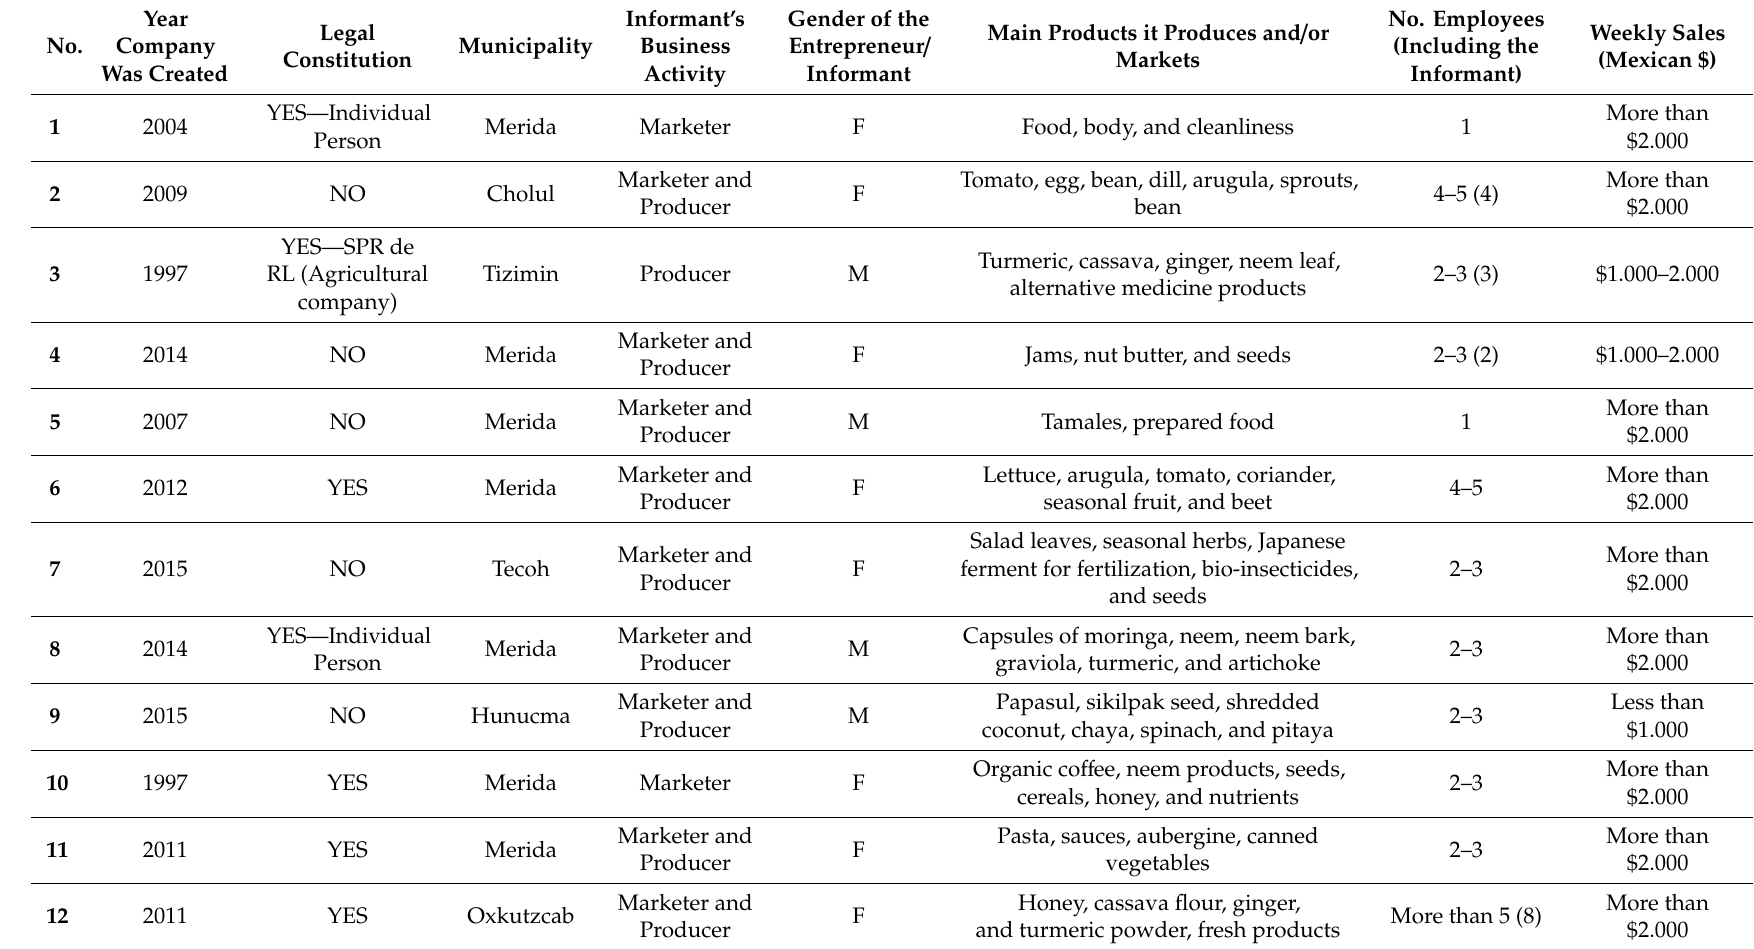
Table A1. Characterization of the agro-ecological entrepreneurs interviewed in